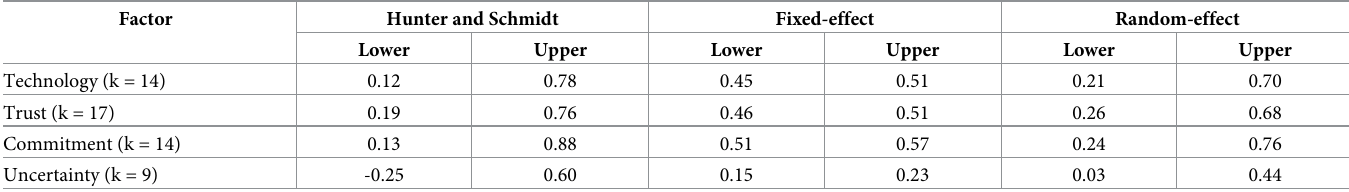
Table 5. Confidence interval between factors and information sharing.